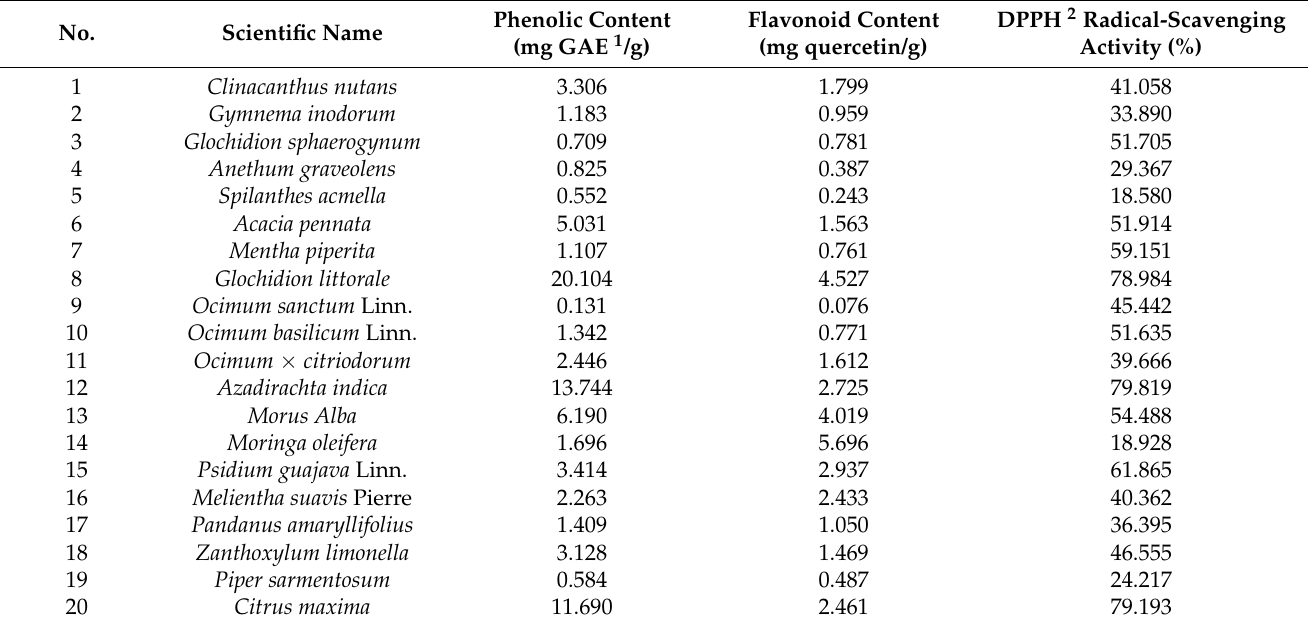
Table 1. Properties of the plants investigated in this study.